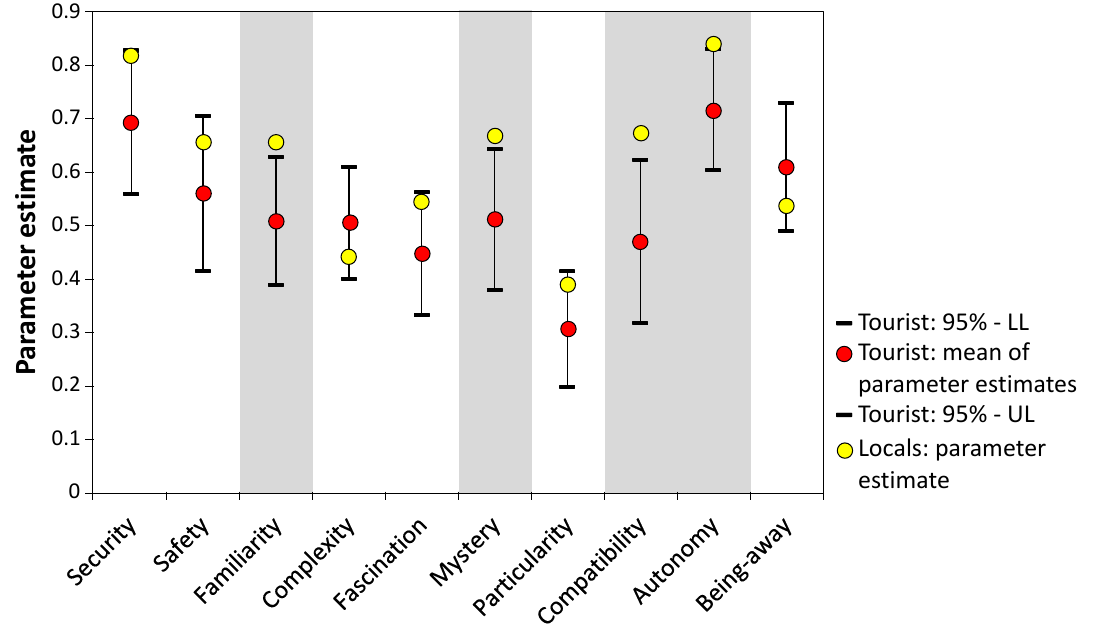
Fig. 3: The results of the sub-sampling approach are shown. The lower limit (LL) and the upper limit (UL) of the 95%-confidence interval for each item are given. The overall confidence level was kept at 95% by applying a Bonferroni- Holm correction. A statistically significant difference in the parameter estimate of the locals from the one for the tourists is indicated by the shaded